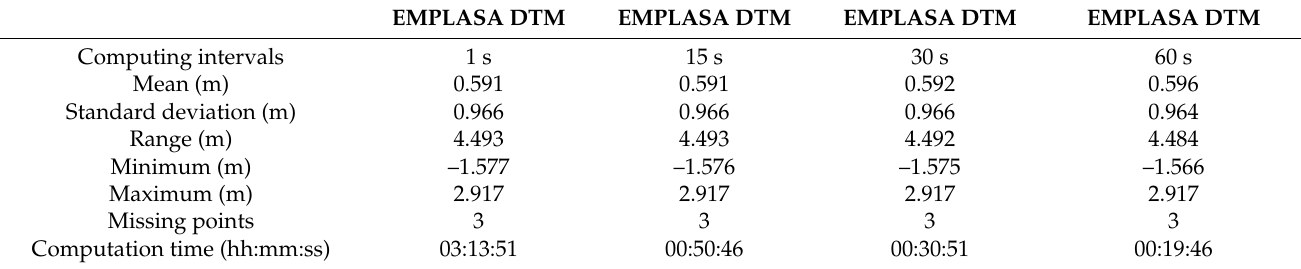
Table 4. Descriptive statistics of the residuals between the 82 validation points and their correspond- ing points in the HEC-RAS simulation with the EMPLASA DTM (5